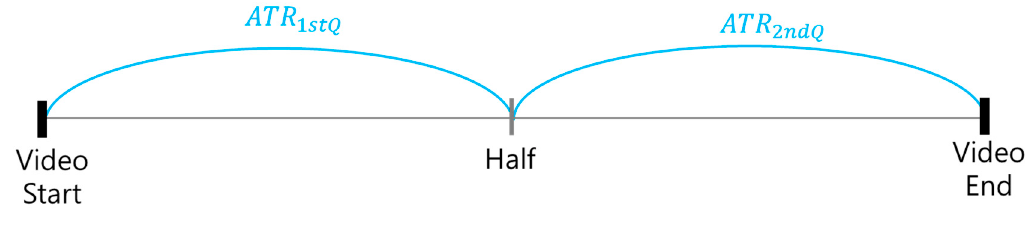
Figure 6. Quiz answer submission time range.